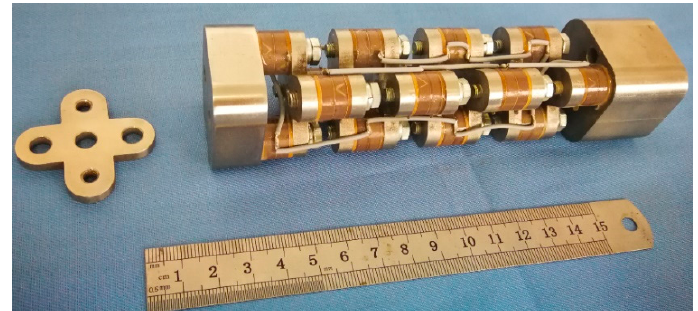
Figure 2. The cascade-connected transducer with eight segments.